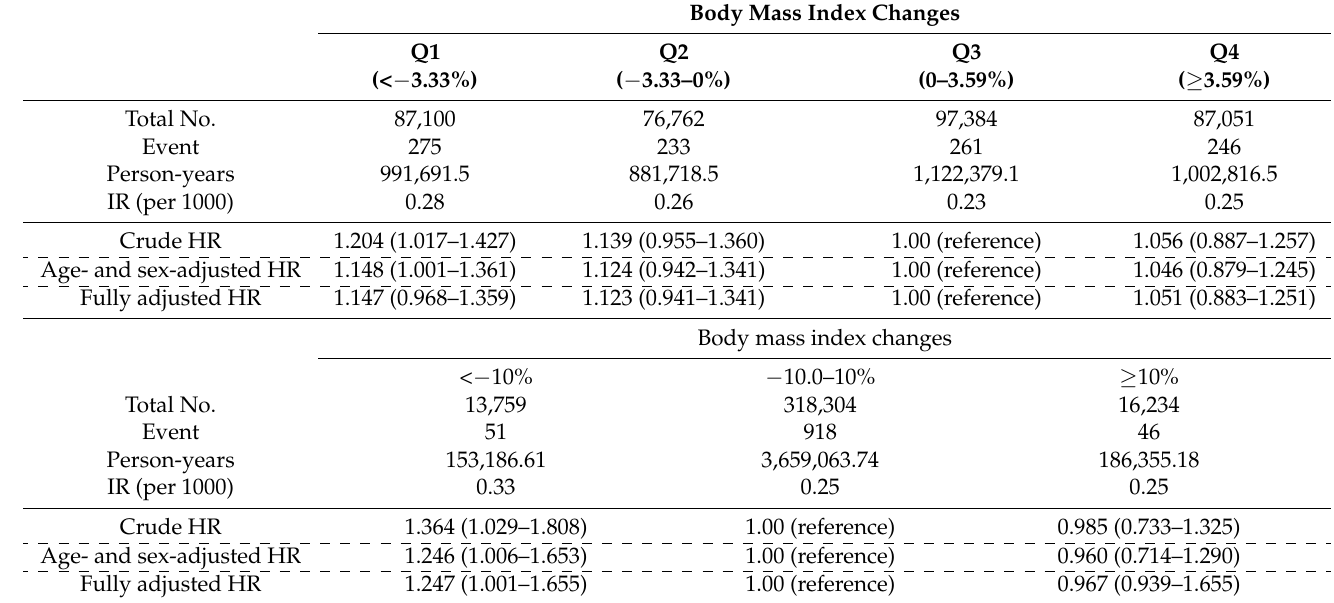
Table 3. Hazard ratios (HRs) and 95% confidence intervals (CIs) for the incidence of recurrent and persistent hematuria in glomerular disease according to body mass index (BMI) changes during the follow-up